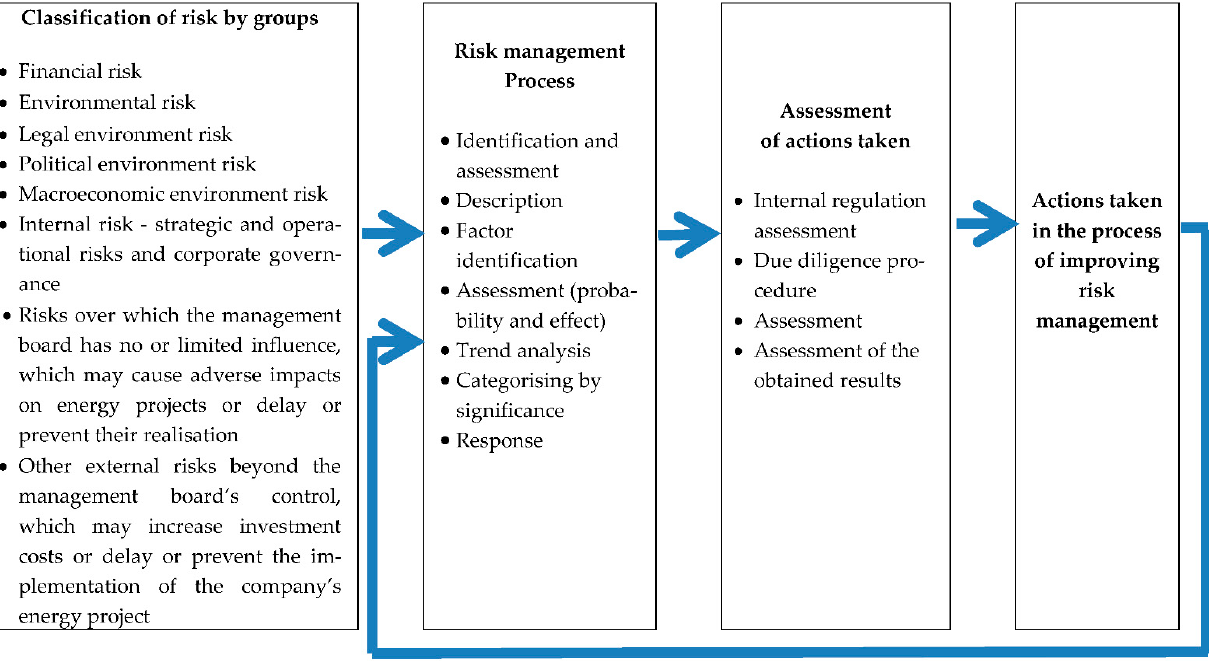
Figure 1. Risk information disclosures in socially responsible energy company reports—a model of classifying management risks, business activity risks, and SD. Source: own research.